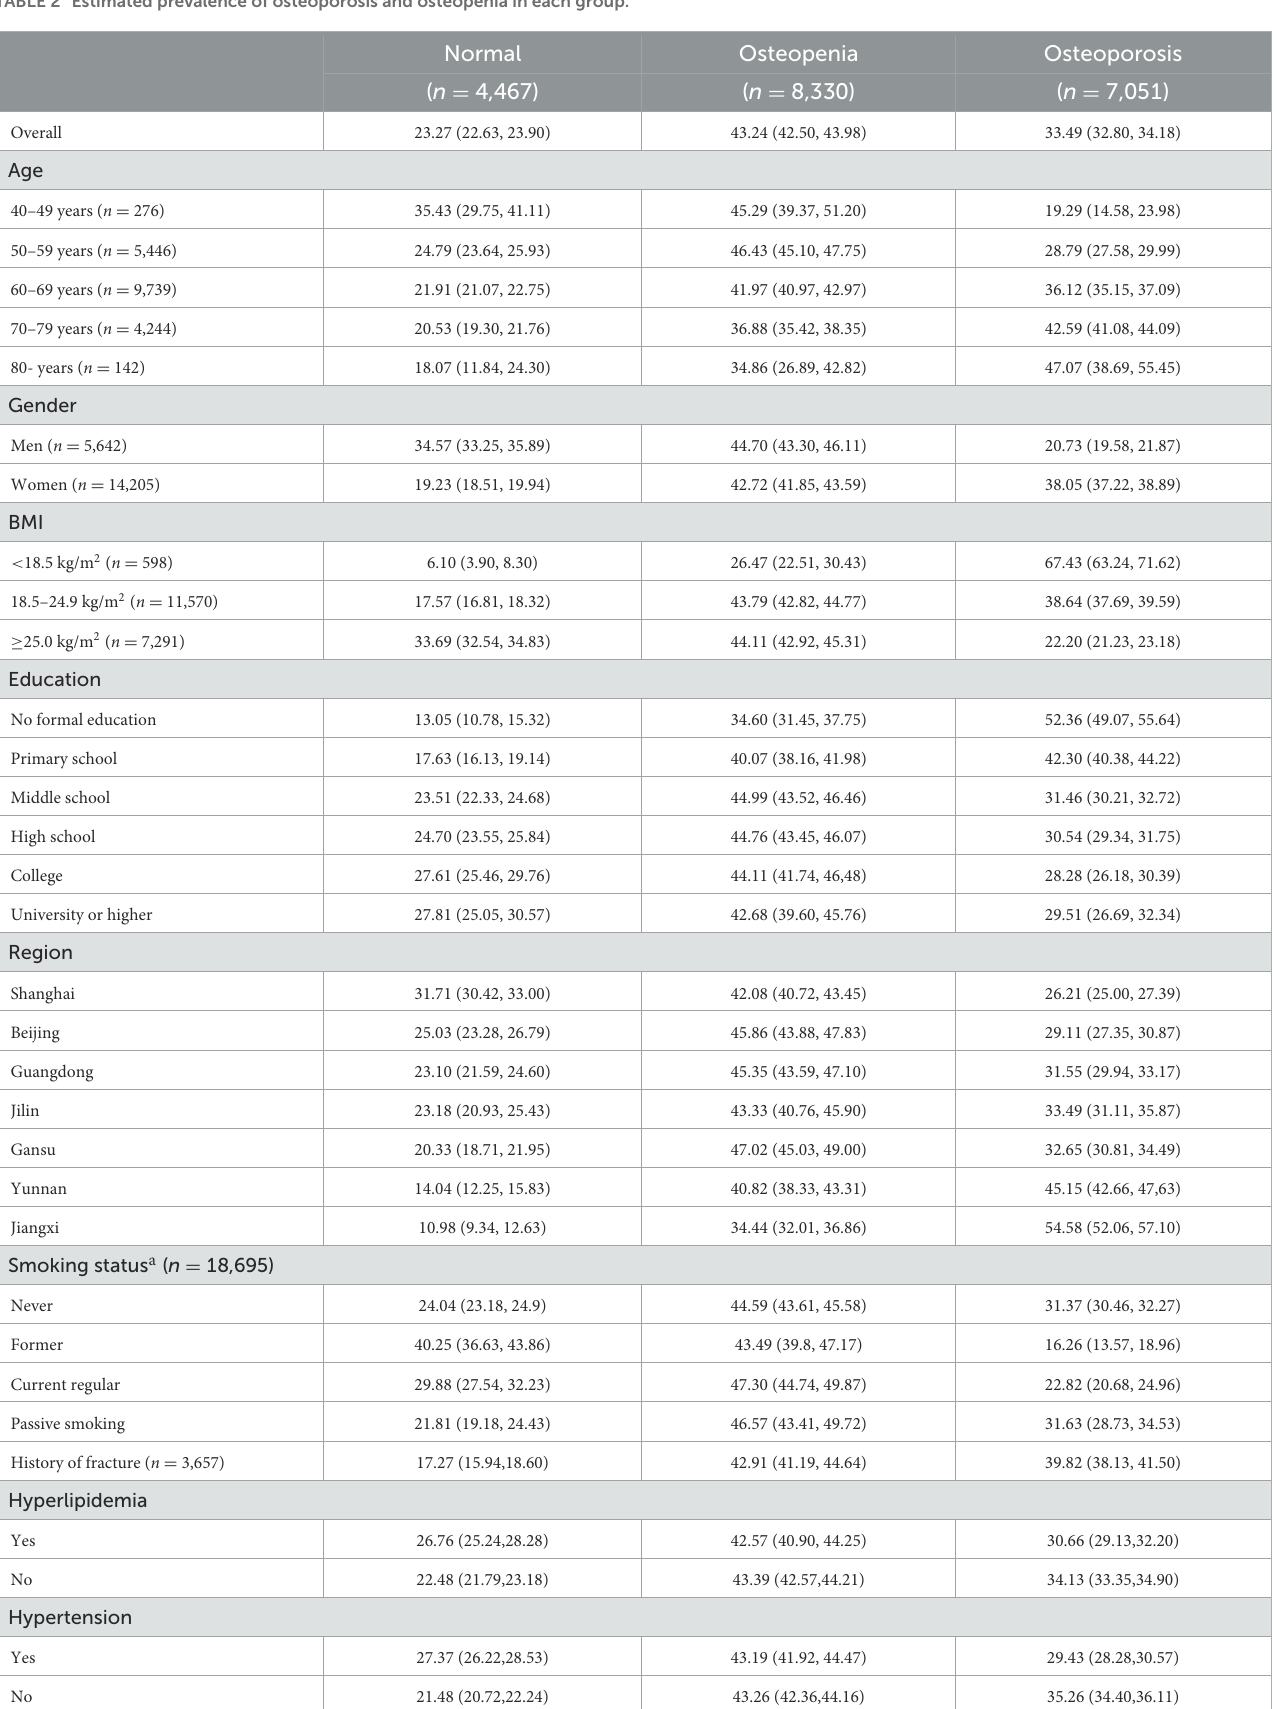
TABLE 2 Estimated prevalence of osteoporosis and osteopenia in each group. Normal Osteopenia